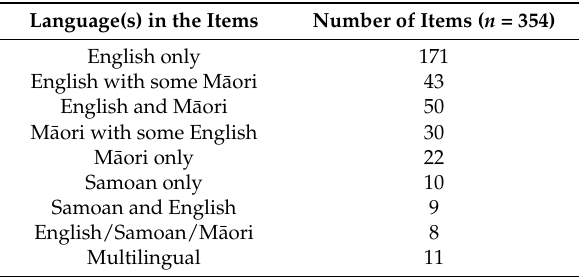
Table 2. Pictures containing linguistic items across the six early childhood education centres (ECCs) classified on the basis of the language(s) they contained.